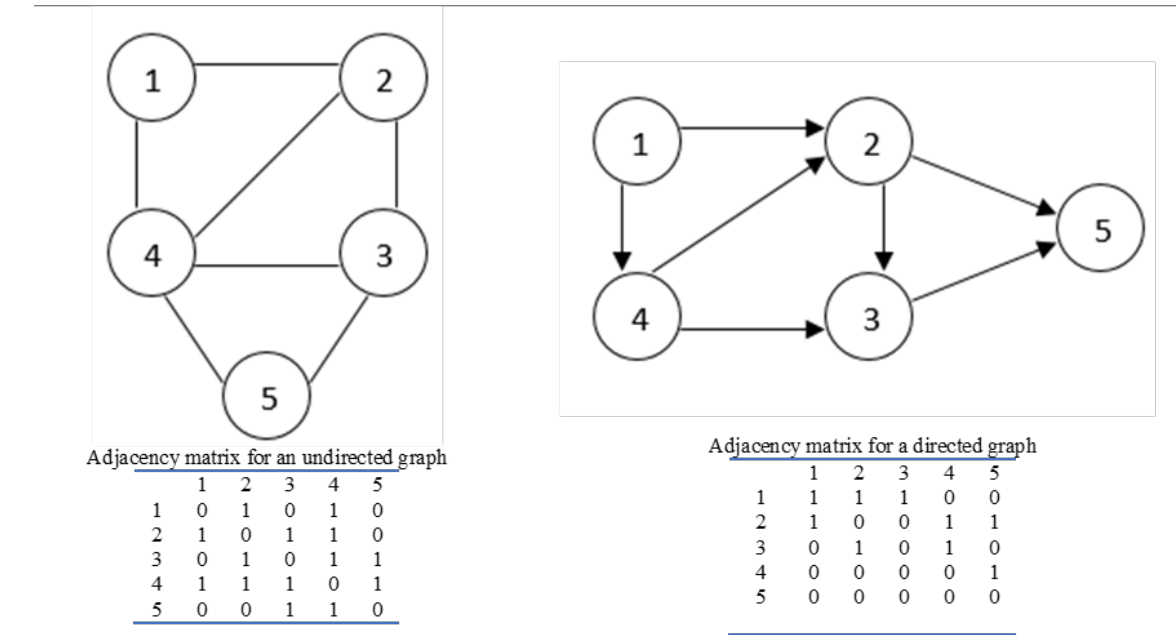
Figure 1. An indication of directed and undirected graphs showing their adjacency matrices.